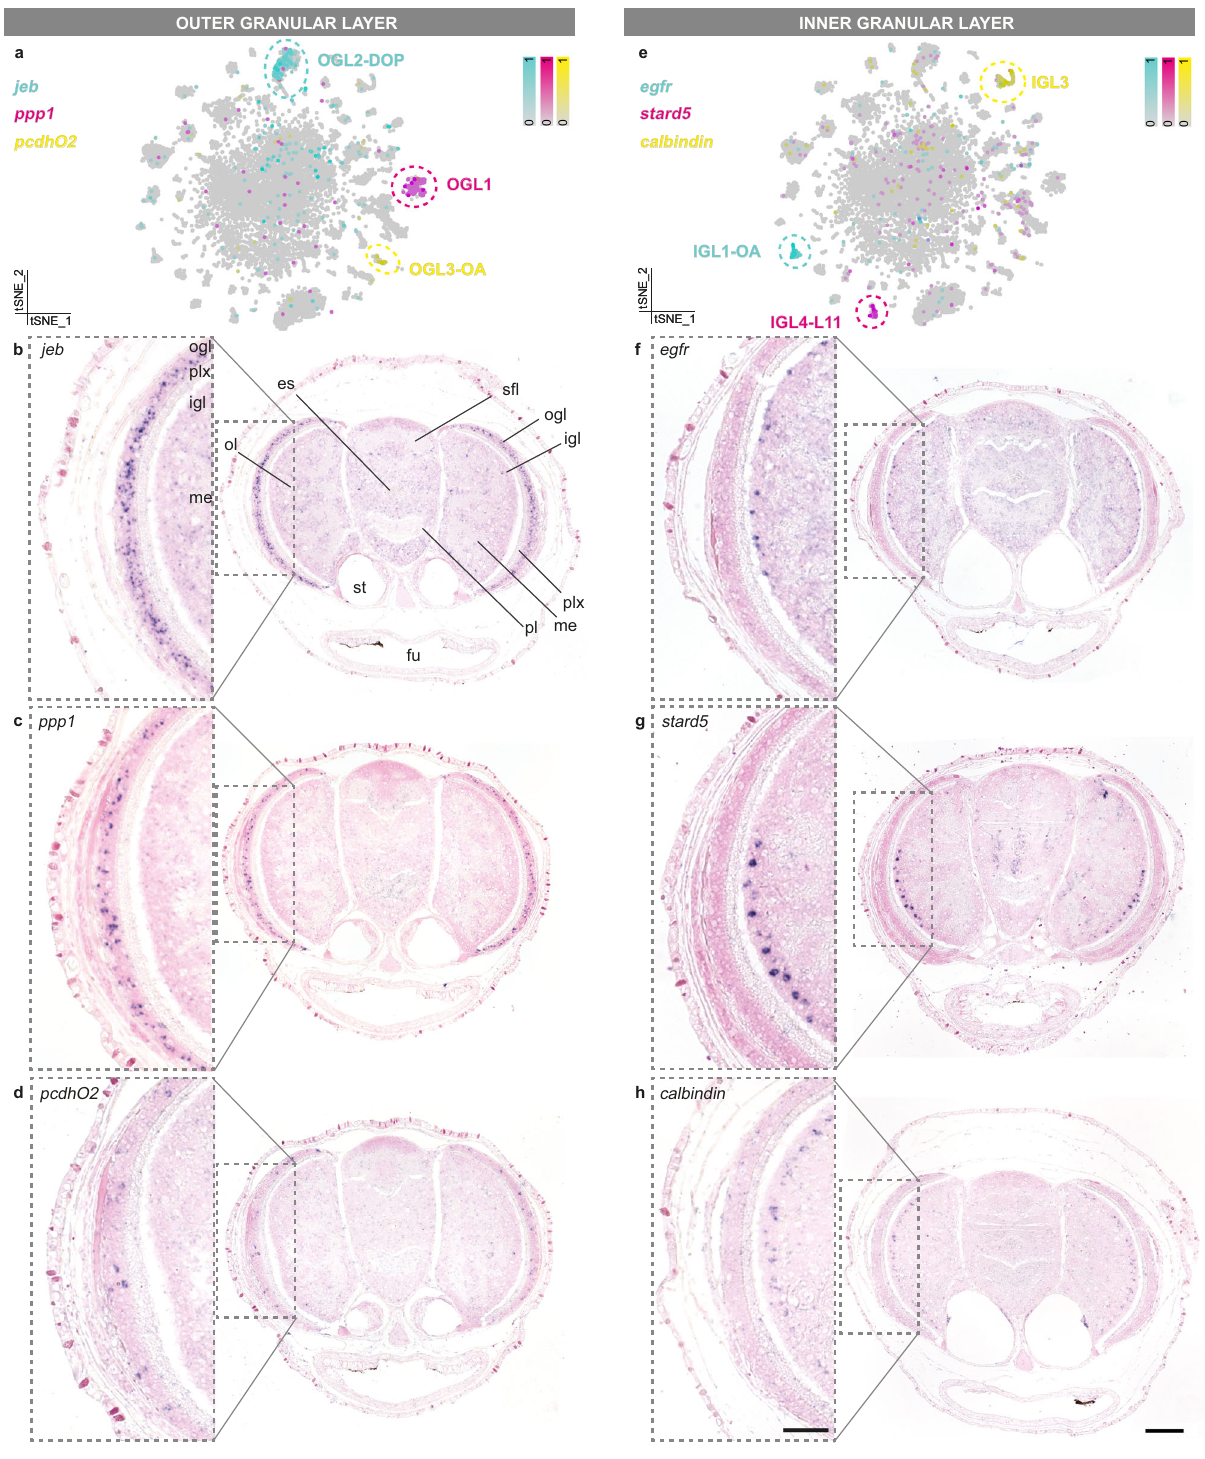
Fig. 3 | Opticlobe cell-typediversity. a Markerexpression of outergranular layer celltypes. b jeb isexpressedthroughoutdopaminergicneuronsintheogl. c ppp1 is expressed within the ogl, in fewer cells than jeb . d pcdhO2 is expressed in ogl octopaminergic neurons. e Marker expression of inner granular layer cell types. f egfr isexpressedintheouterregionoftheigl. g stard5 isexpressedmoreinteriorly withinthe iglthanthe egfr +cells. h calbindin isexpressed in the most interiorside